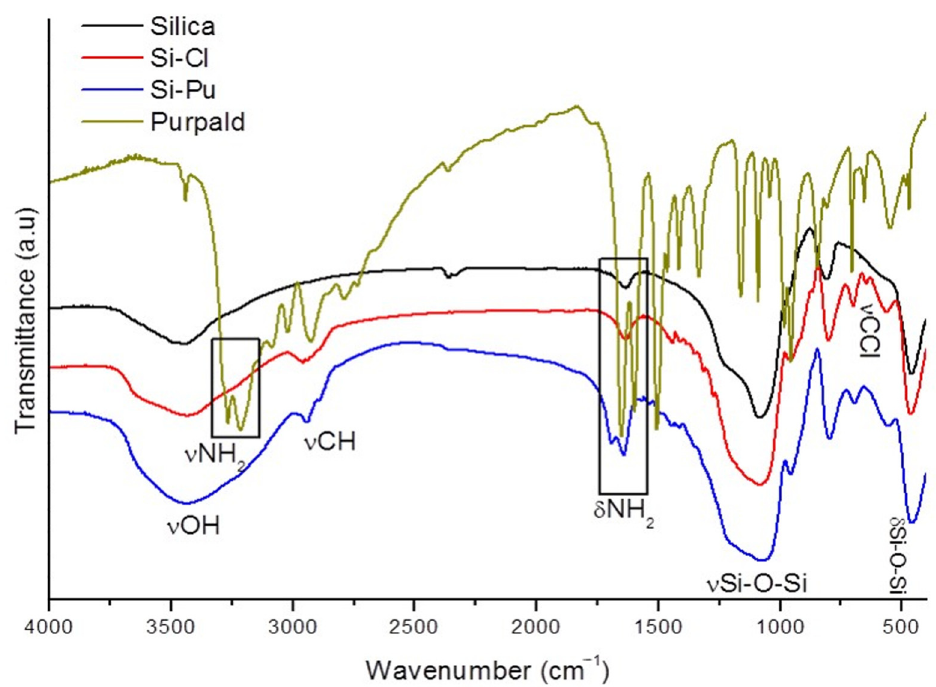
Figure 3. Infrared spectra of the non-modified silica, the material Si-Cl, the ligand (Purpald) and the functionalized material (Si-Pu).